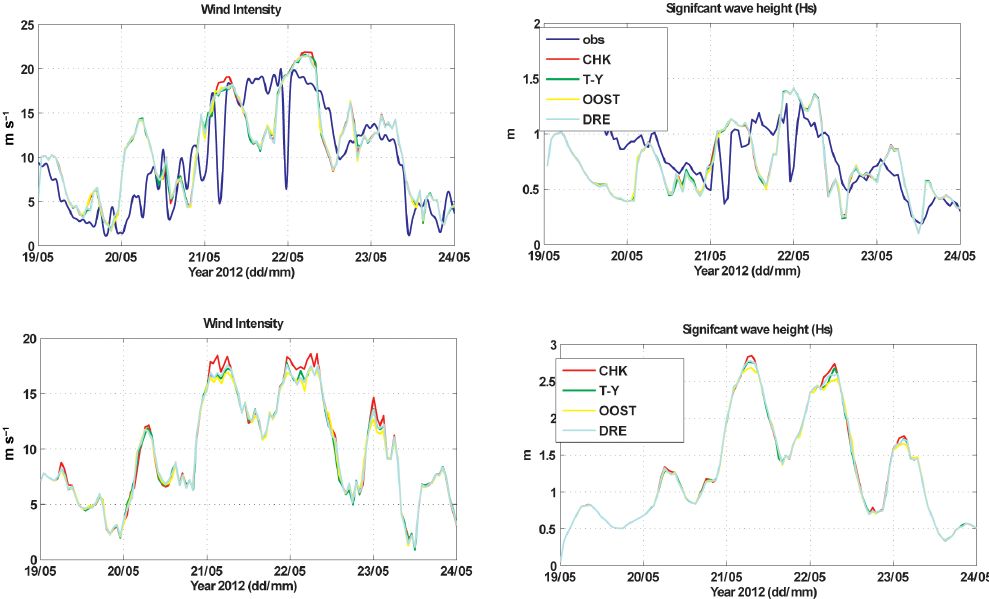
Figure 10. Wind intensity (left panels) and significant wave height (right panels) for the wind jet energetic event for the observational (top panels) and control (bottom panels)